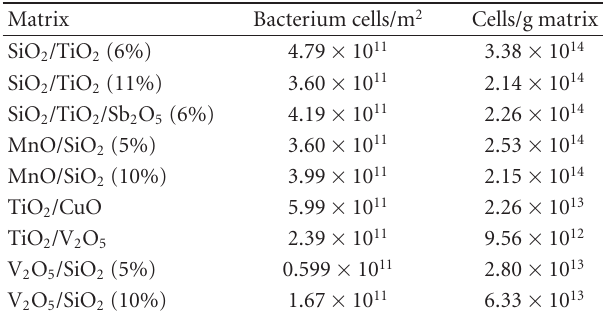
Table 2: Surface densities and quantity of bacterial cells on the